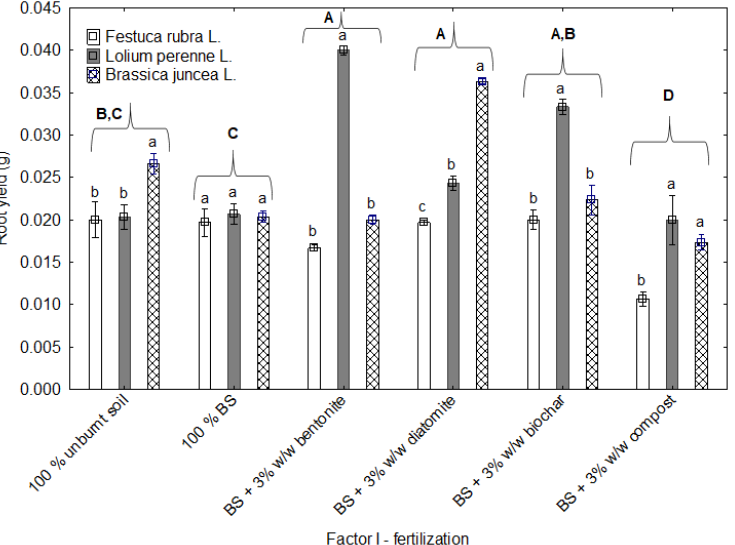
Figure 13. Under-ground biomass (root) yield of Festuca rubra L., Lolium perenne L. and Brassica juncea L. from a pot experiment carried out for unburnt soil, burnt soil and burnt soil supplemented with different amendments. Average values of plant biomass (n = 3) ± SE are presented; different small letters indicate significant differences between individual plants within one variant. Different uppercase letters in bold indicate significant differences in average (n = 9) plant biomass yield between individual variants.